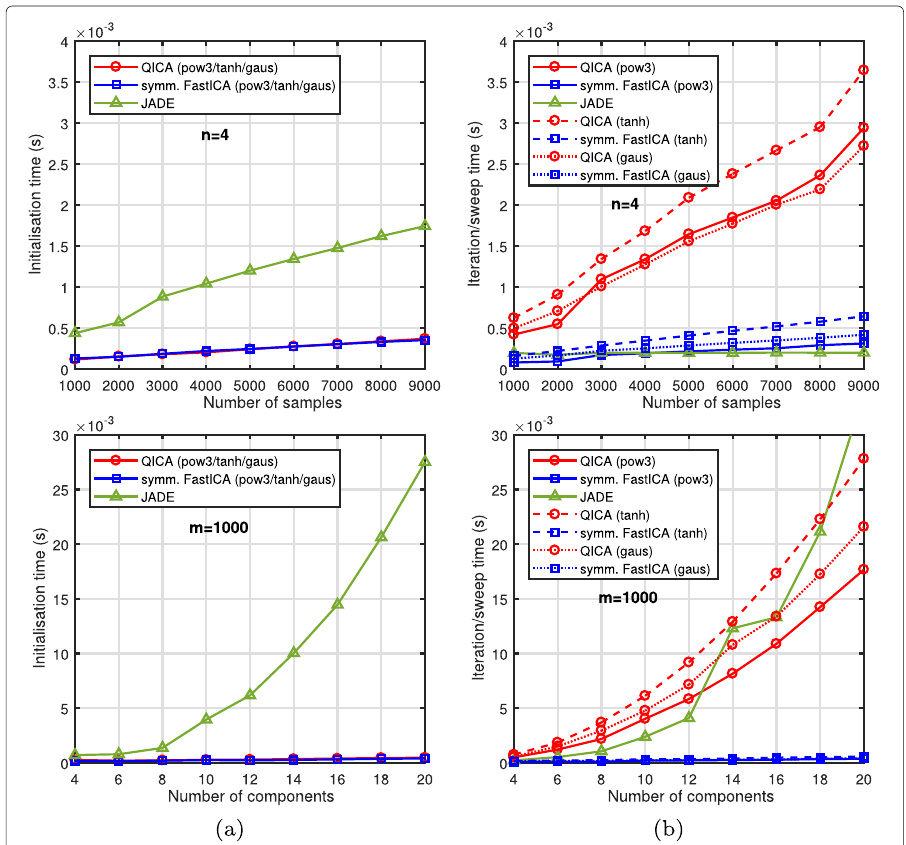
Fig. 7 Execution times obtained for QICA, symmetric FastICA, and JADE algorithms for various numbers of samples with fixed n = 4 (top) and various numbers of components with fixed m = 1000 (bottom). a Initialization time. b Average time of single